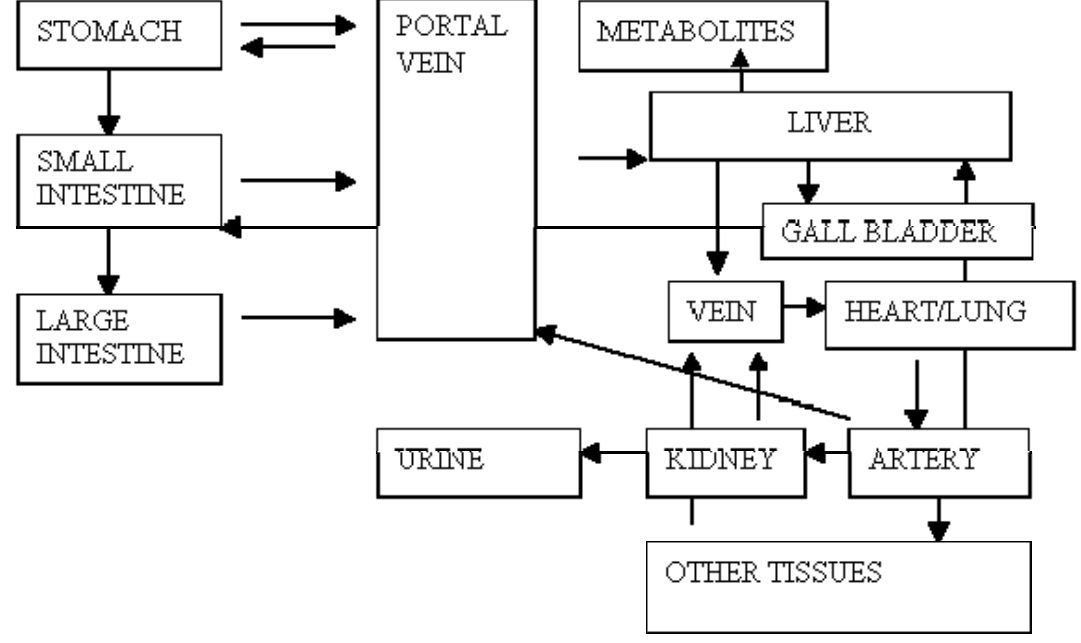
FIGURE 10 . Schematic of a physiological model which can be readily simulated using the spreadsheet technique. model this is arranged by entering the appropriate formulae in the cells for both the small intestine and the gall bladder. For example, the gall bladder contains the